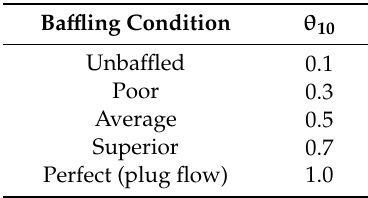
Figure 4. Numerical conservative tracer analysis: ( a ) RTD; ( b ) CRTD. Table 3. Ba ffl ing classifications and factors